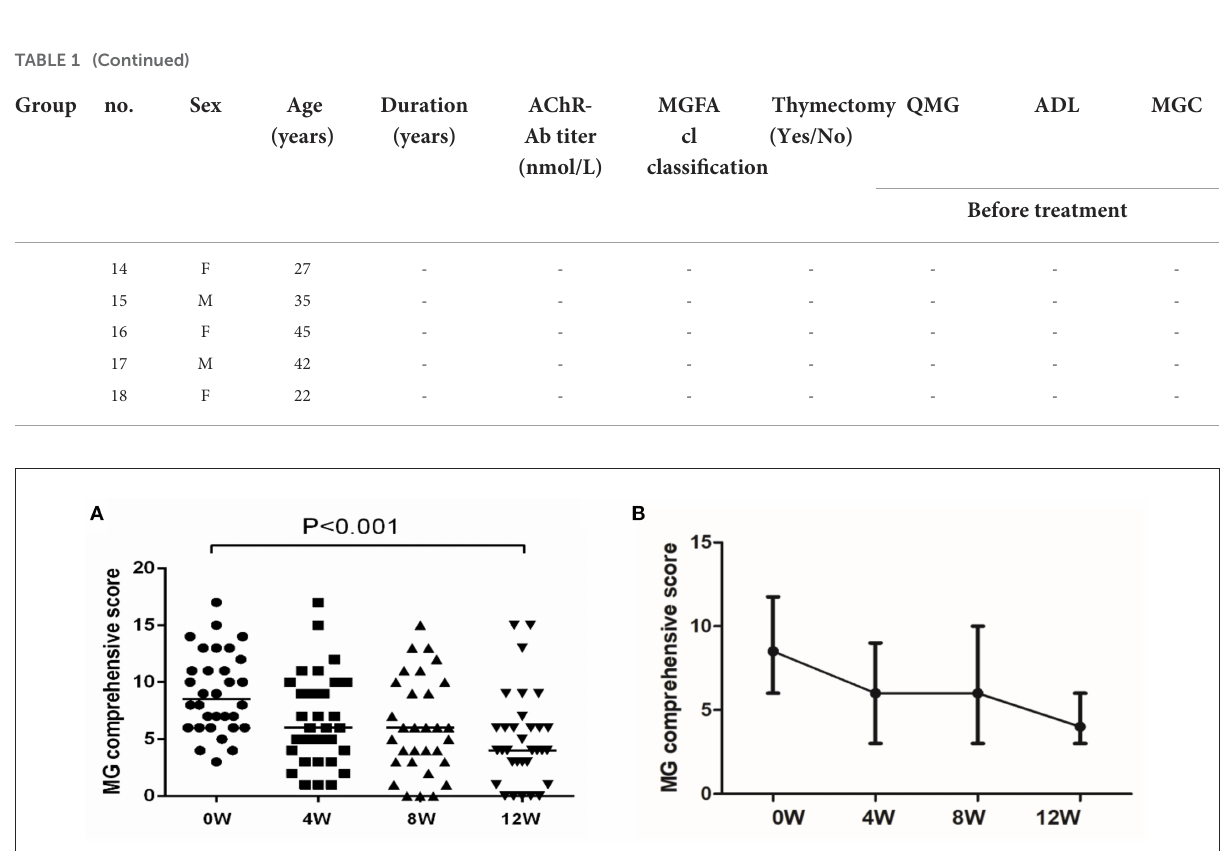
FIGURE1 Changes in MGC during treatment with leflunomide combined with low-dose prednisone. (A) MGC at each follow-up time point. Reproduced with permission from Huang et al (5). (B) Changes in MGC. The MGC was a continuous variable with a non-normal distribution; we compared the values using a paired rank sum test.